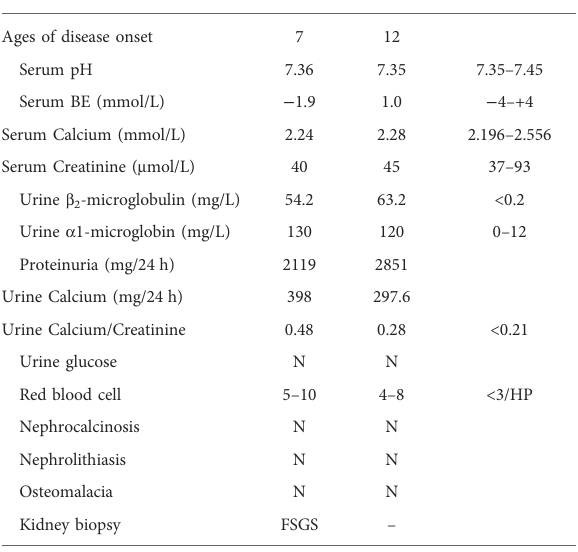
TABLE 1 Laboratory information of the proband and his cousin.